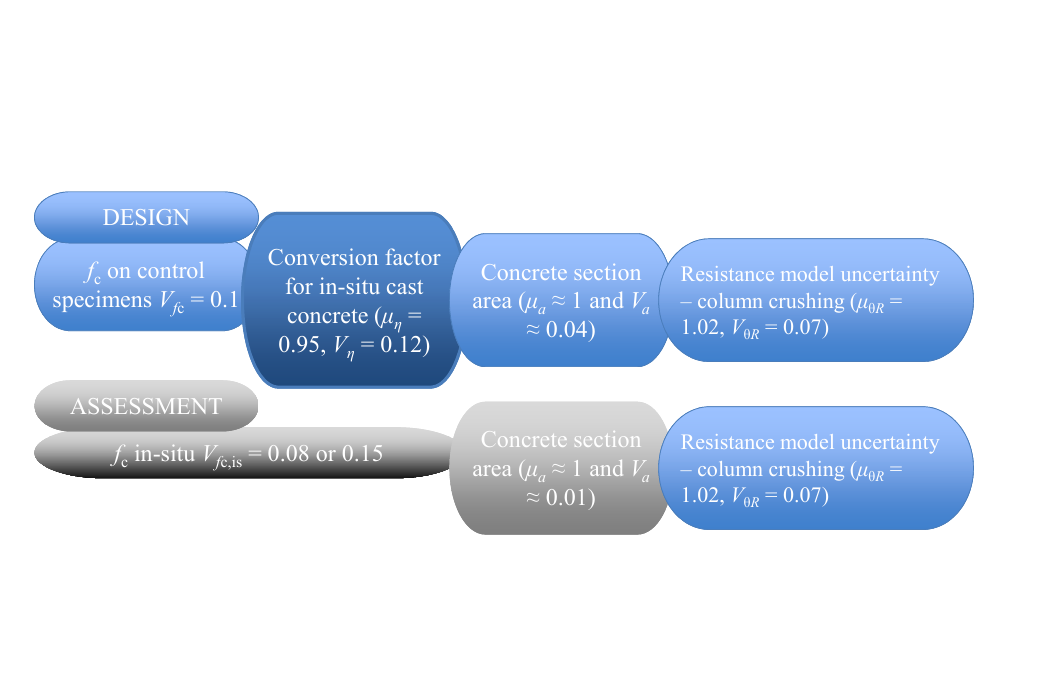
to be applied in conjunction with advance